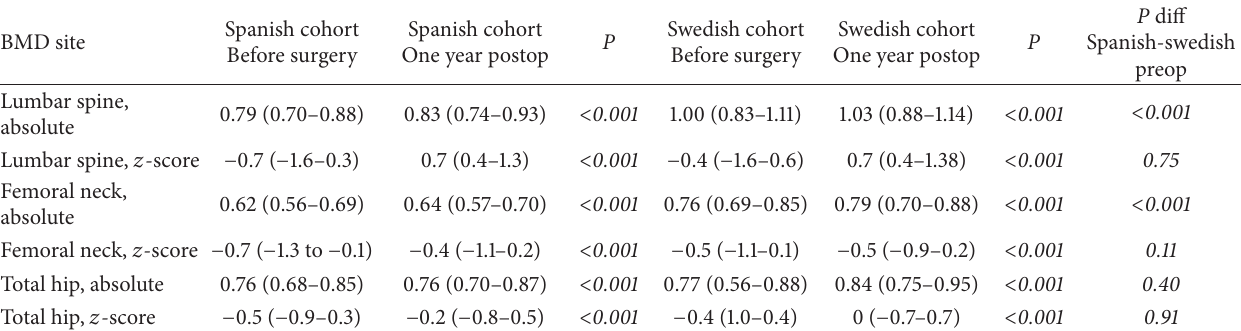
Table 3: Bone mineral density before and one year after surgery for primary hyperparathyroidism. Medians (IQR) Wilcoxon’s signed rank test.